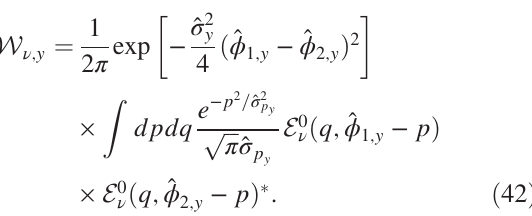
FIG. 3. Convergence of the mode representation toward the Gaussian-Schell model. The red solid line and green dashed line graph the normalized difference of two measures of coherence, the number of modes M from Eq. (25) and the peak brightness T divided by the flux ℬ 0 from Eq. (26). In both cases the Gaussian- Schell model underestimates the number of modes (overestimates the coherence). The blue dashed line quantifies the rms error Δ [Eq. (44)] when approximating W ν given by (42) with W GS ν ;y ;y from Eq.